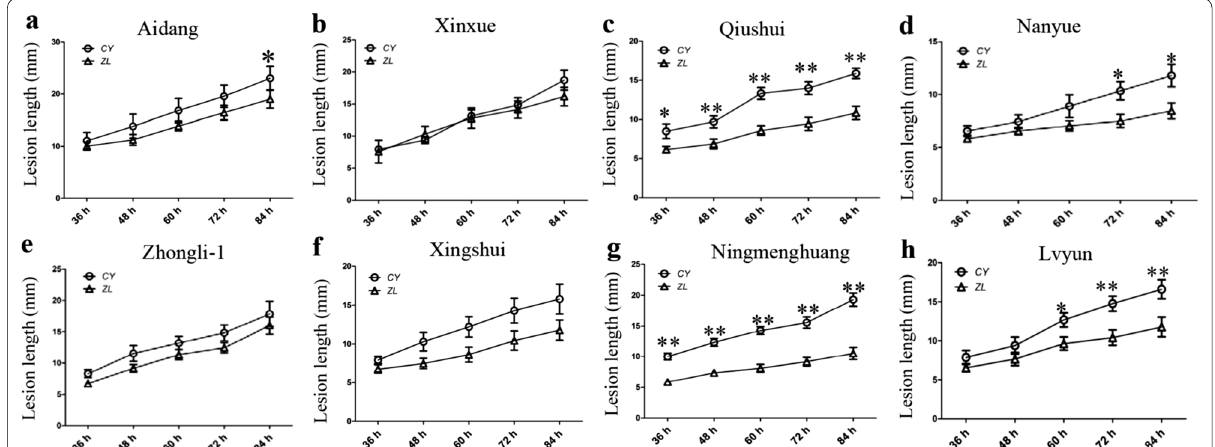
Fig. 7 Pathogenicity of CY-2 and ZL-4 isolates on eight sand pear varieties. The virulence of the two isolates on eight sand pear varieties, including Aidang ( a ), Xinxue ( b ), Qiushui ( c ), Nanyue ( d ), Zhongli-1 ( e ), Xingshui ( f ), Ningmenghuang ( g ) and Lvyun ( h ), was examined. Fungal plugs were placed on the wounded fresh branches. Lesion length was measured at 36, 48, 60, 72 and 84 h post-inoculation (hpi). The column graph was generated using the GraphPad prism software based on these data. The photos were collected at 84 hpi. CY indicates CY-2 isolate, ZL indicates ZL-4 isolate. Bar 10 mm. Every isolate was inoculated on five branches, and data were analyzed using ANOVA. * P < 0.05, ** P < =